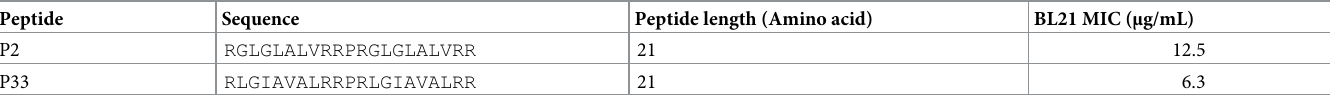
Table 1. Amino acid sequence and MIC of Pept-in P2 and